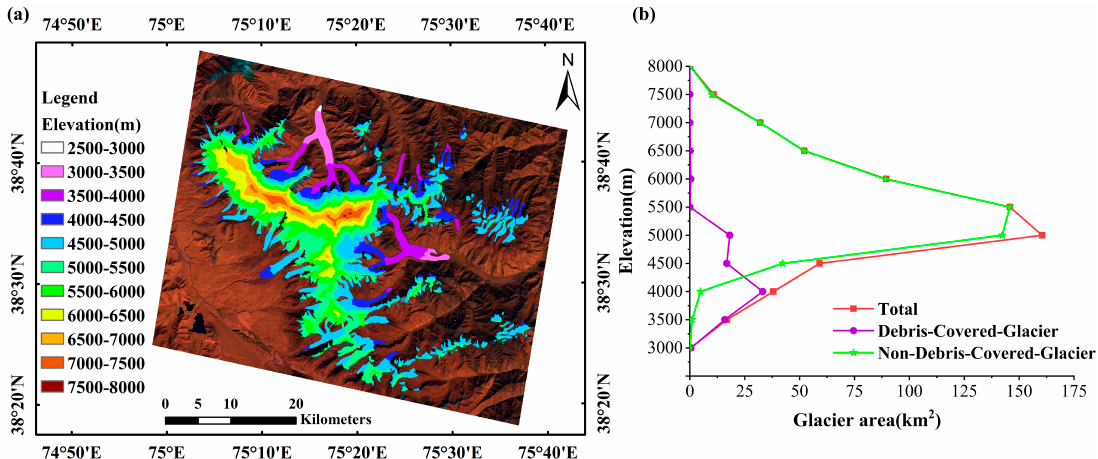
Figure 14. ( a ) Distribution of glacier elevation (background: a false-colour composite with a band combination: R = shortwave infrared band (band 6), G = near-infrared band (band 5) and B = blue band (band 2) of the Landsat-8 OLI image acquired on 20 October 2017); and ( b ) hypsometry of all glaciers in the study